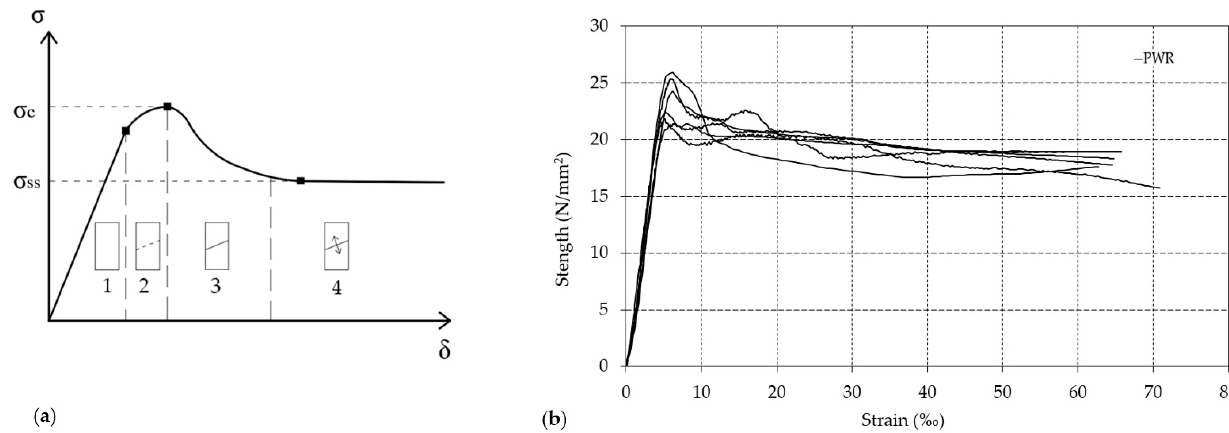
Figure 4. Strength–strain graphs for pieces of wood subjected to compression testing. ( a ) Idealized graph, ( b ) Real graphs.